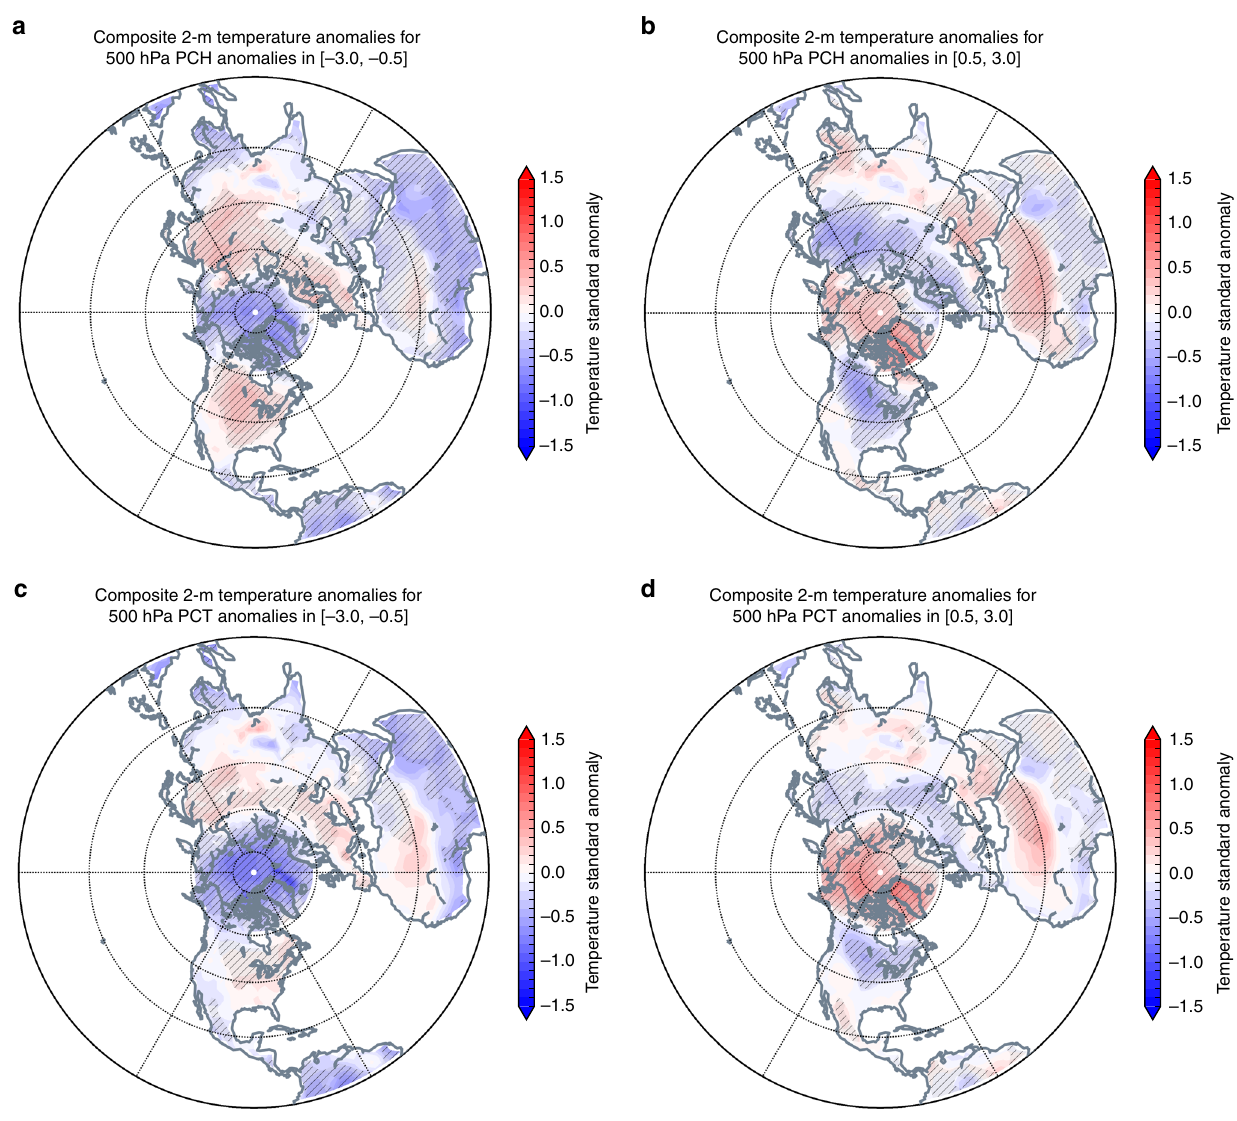
Fig. 7 As the Arctic warms the continents become colder. Northern Hemisphere surface temperature anomalies plotted for 500 hPa PCH anomalies binned on the intervals a [ − 3.0, − 0.5], b [0.5, 3.0] and 500 hPa PCT c [ − 3.0, − 0.5], and d [0.5, 3.0] for all winters 1950 – 2016. Climatological averages computed over the period 1981 – 2010. Where difference was found to be statistically signi fi cant above 95% is hatched in light gray (e.g., [ − 3.0, − 0.5] to [0.5, 3.0]). We also tested for fi eld signi fi cance in all plots and the differences were found to be highly signi fi cant. Ocean mask was applied south of 60°